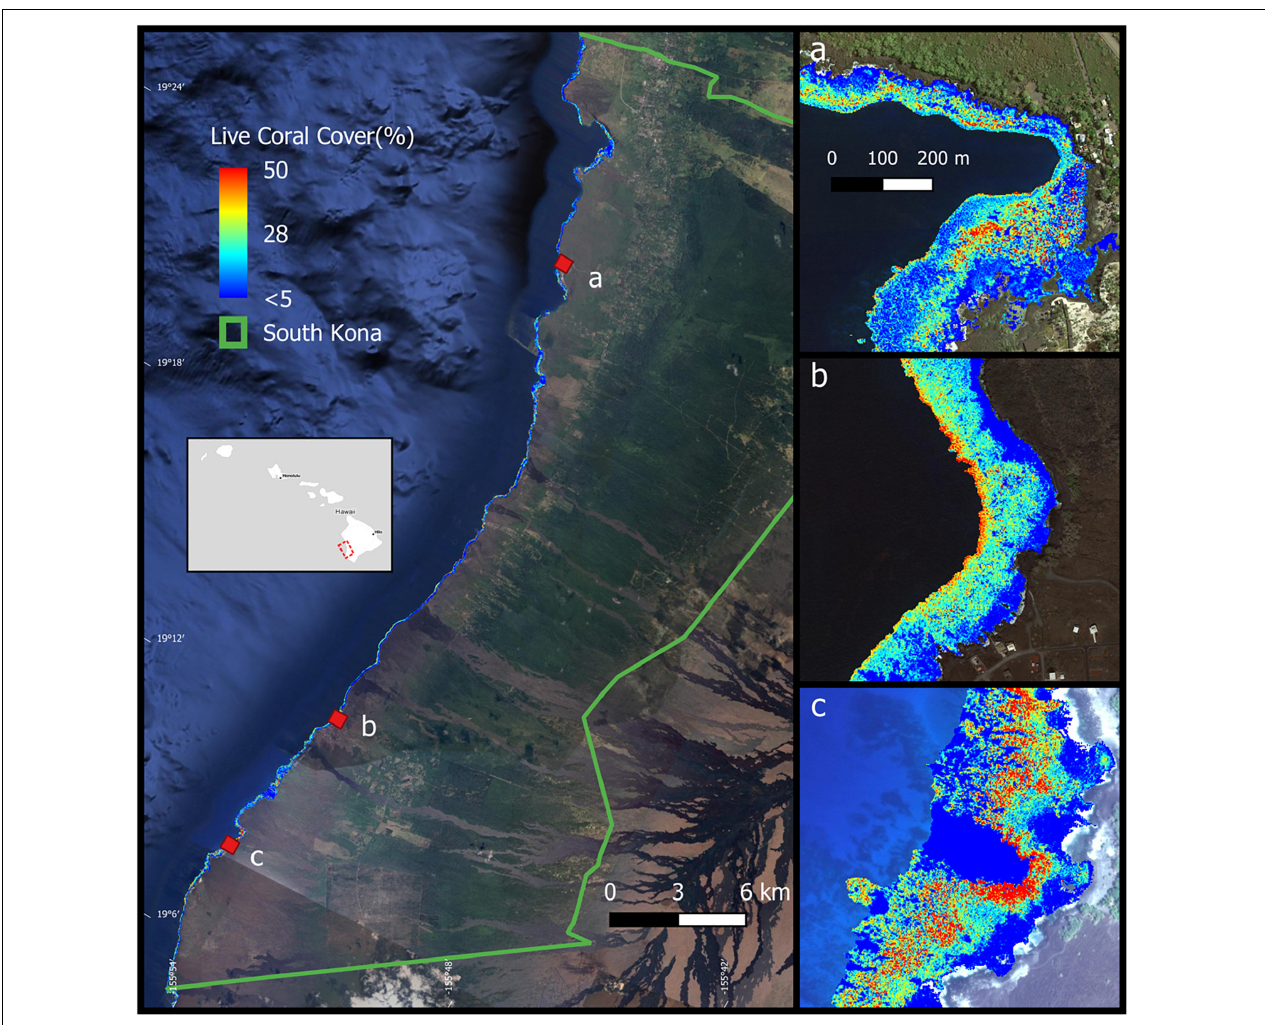
FIGURE 1 | The location of South Kona District in green lines on the left, with live coral cover mapped along the coast (from Asner et al., 2020b). Example areas of live coral cover are shown at (a) H ¯ onaunau Bay, (b) P ¯ ap ¯ a Bay, and (c) Okoe-Kapua Bay. Background imagery retrieved from Google, ©2020 Digital Globe, ©2021 Maxar